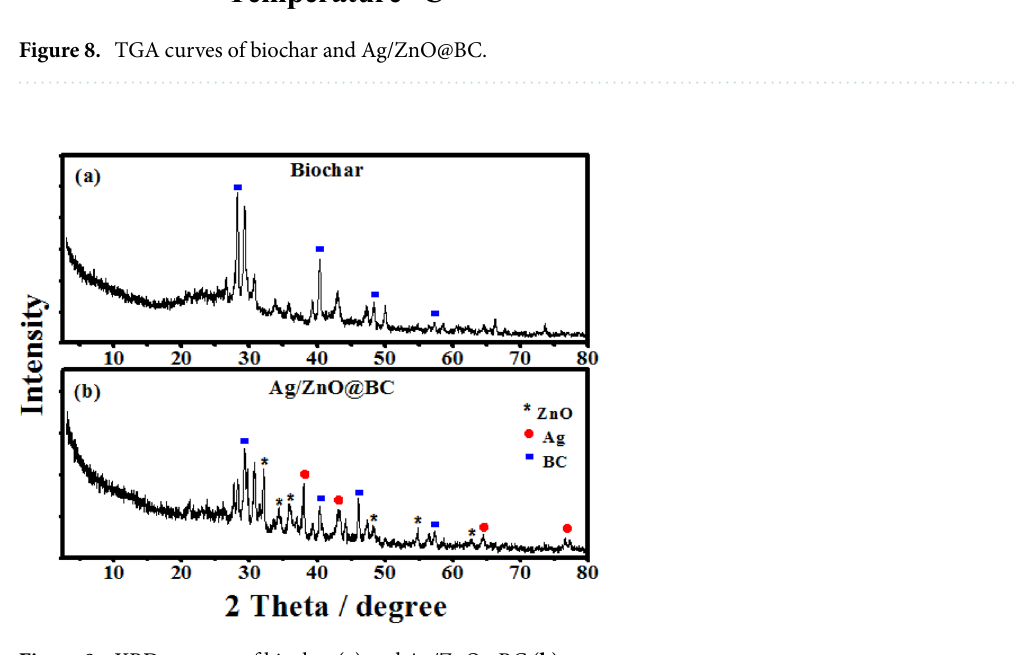
Figure 9. XRD patterns of biochar ( a ) and Ag/ZnO@BC ( b